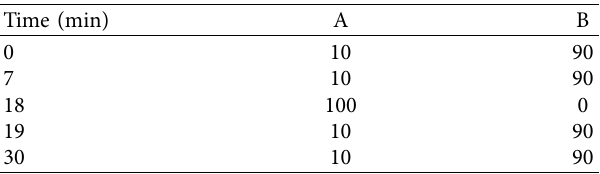
Table 1: Analytical conditions of high-performance liquid chro- matography for the analysis of